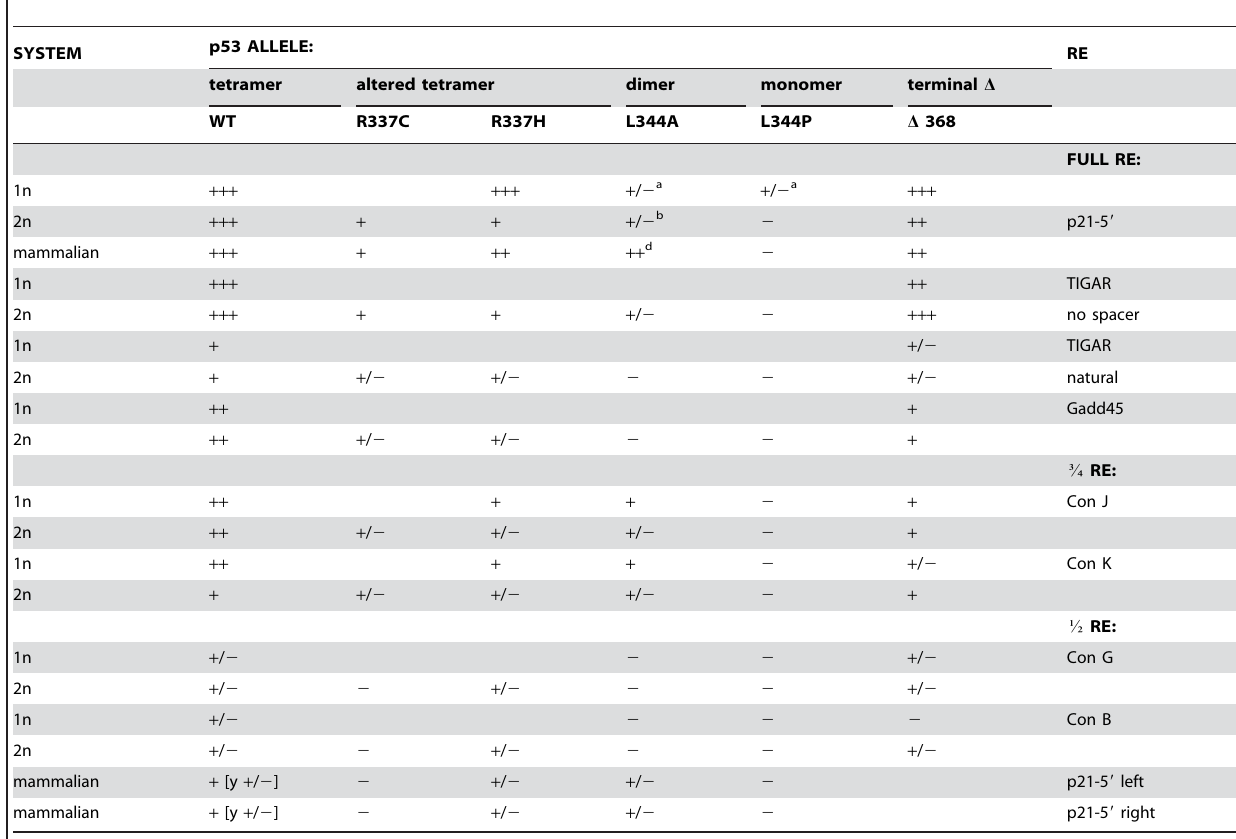
Table 1. Transactivation capacity of WT and mutant p53 towards canonical and nncanonical REs.